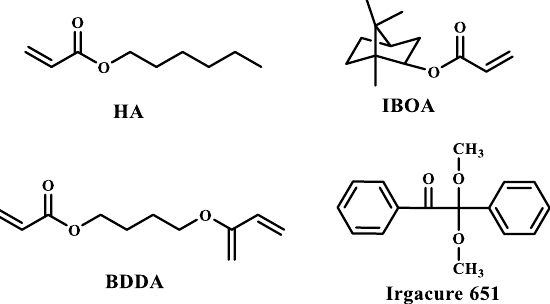
Figure 1. The chemical structural formula of the material